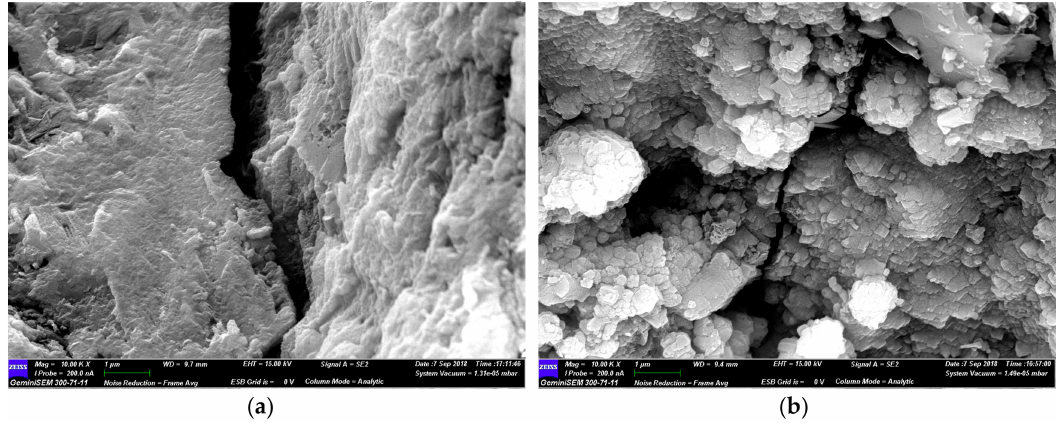
Figure 7. SEM images of micro-cracks in concretes: ( a ) U-RMA / C and ( b ) O-RMA /